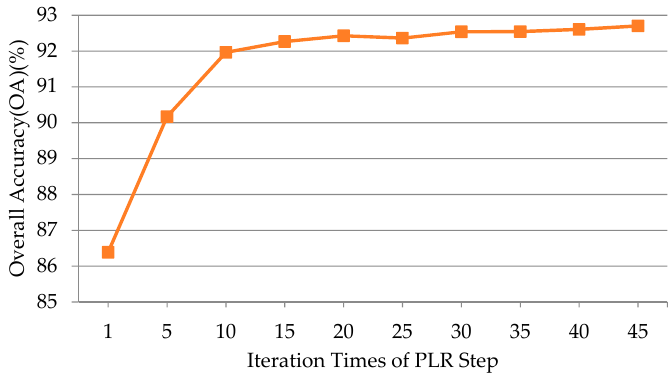
Figure 14. OA of applying SP-KSEM-PLR to the RADARSAT-2 image with different PLR step iteration times.